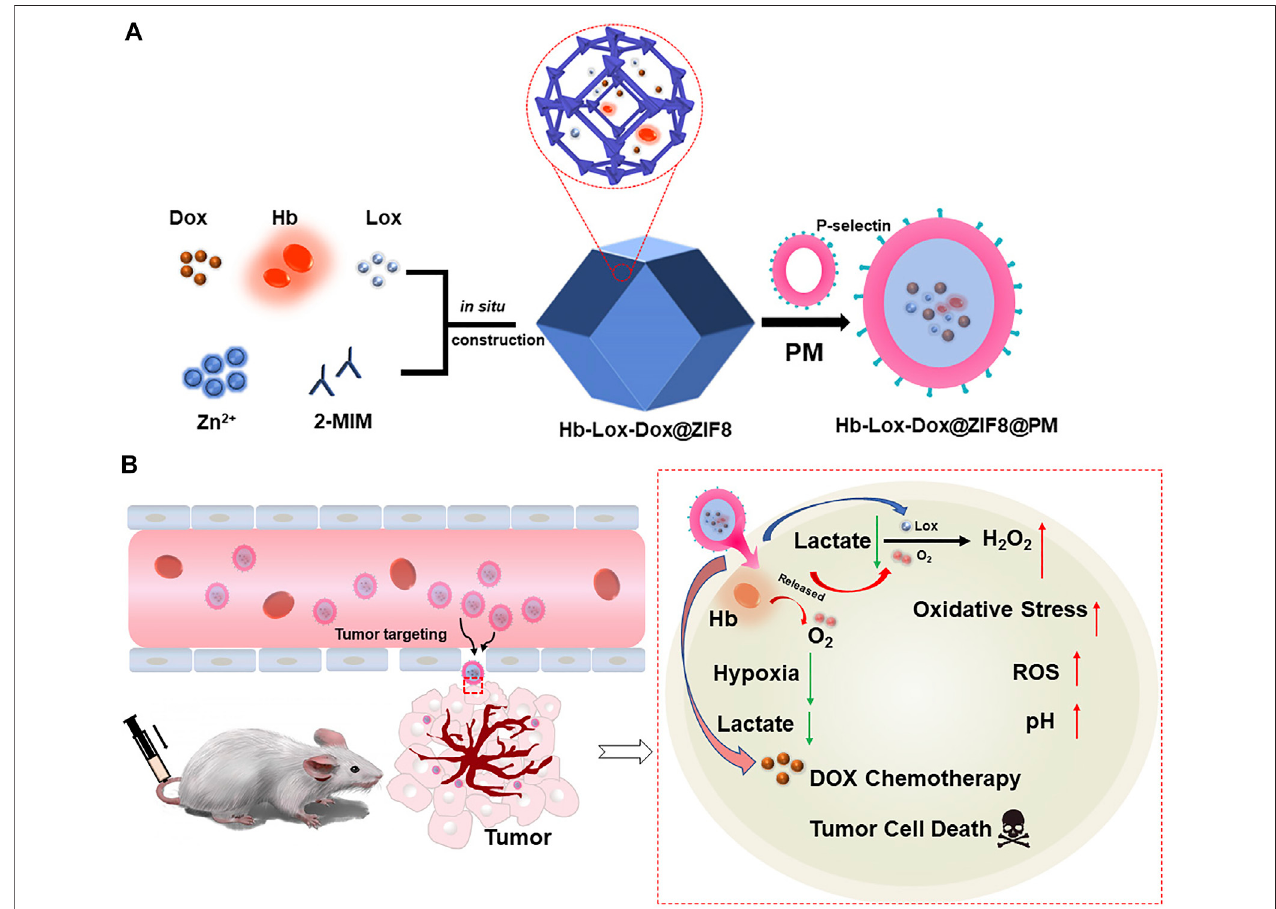
FIGURE 1 | (A) Schematic illustration of the main synthesis procedures of H-L-D-Z@PM NPs; (B) antitumor mechanism of H-L-D-Z@PM NPs.